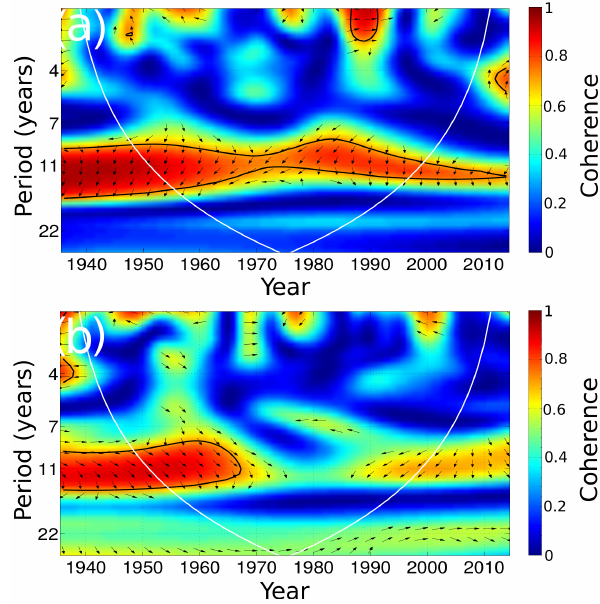
Figure 7. Wavelet coherence spectrum between annual average of the modulation potential and temperature for (a) TOR and (b) IRA. The black arrows represent the phase angle between the modulation potential and the temperature data. Further legend information is the same as for Fig.